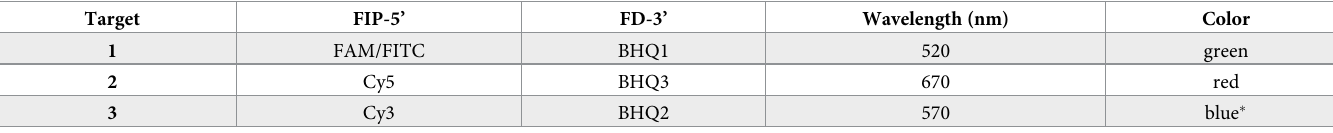
� The color of Cy3 in the spectrum is orange, and the overlapping color of FAM (green) and Cy5 (red) is also orange. To distinguish them, Cy3 is shown in blue in the output